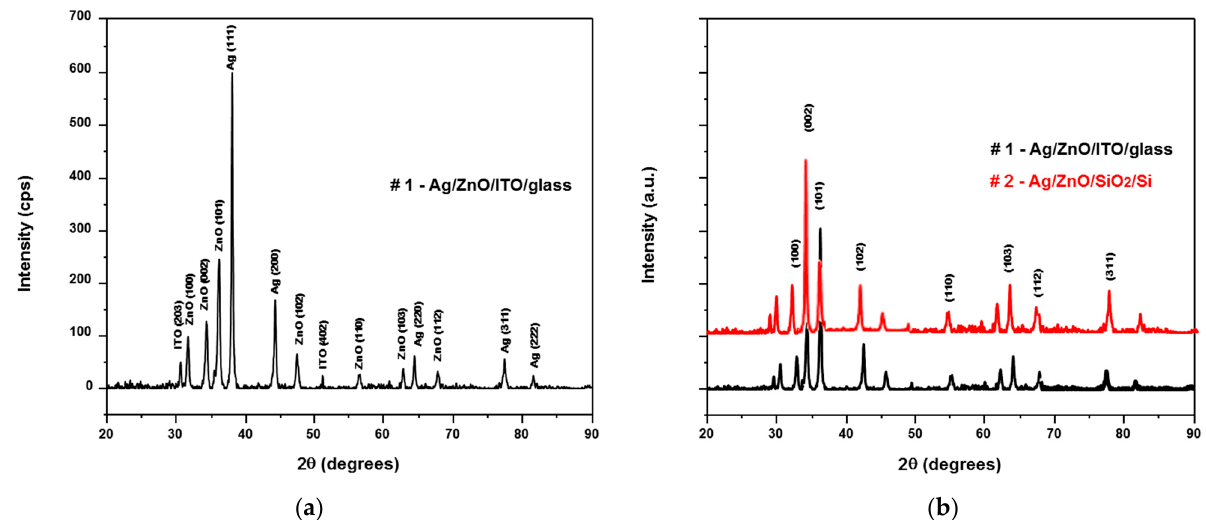
Figure 3. ( a ) XRD for #1 sample as grating nanostructures; and ( b ) XRD both ZnO thin film nanostructures.